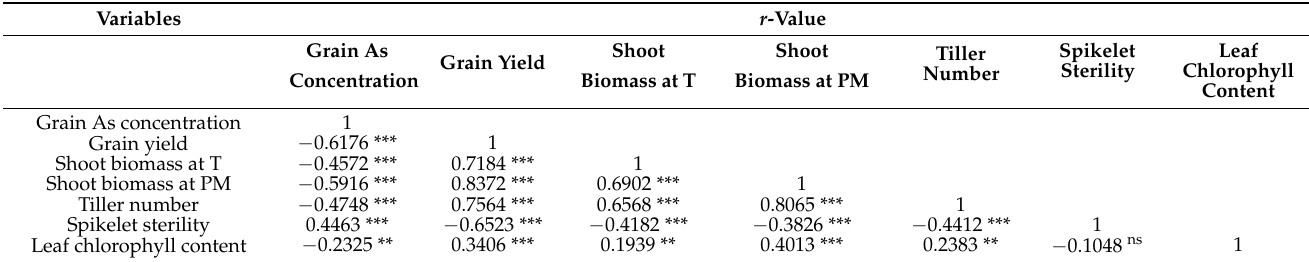
Table 4. Pearson’s correlation matrix of different plant growth and yield parameter with grain arsenic (As) concentration. Variables r -Value Grain As Shoot Shoot Tiller Leaf Spikelet Grain Yield Sterility Number Concentration Biomass at T Biomass at PM Chlorophyll Content Grain As concentration 1 Grain yield − 0.6176 *** 1 Shoot biomass at